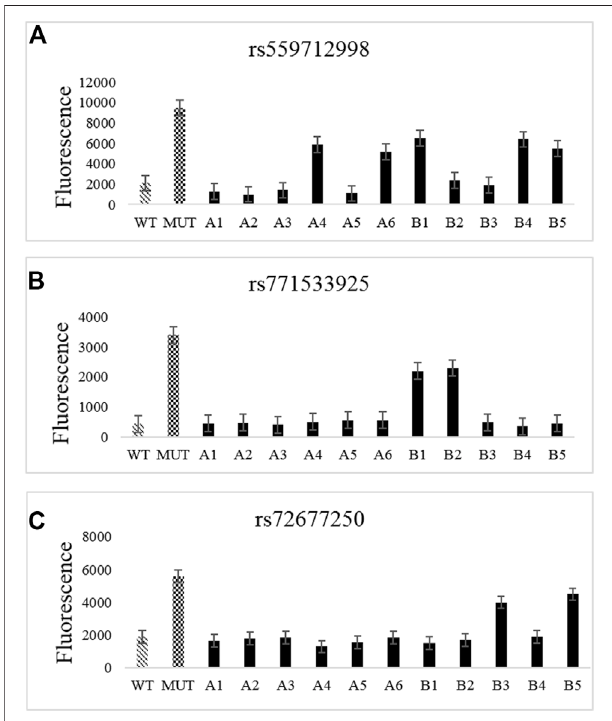
FIGURE 3 | CRISPR-Cas12a analysis of TTN gene mutation loci in familial samples. (A – C) CRISPR-Cas12a test results for rs72677250 (A) ,